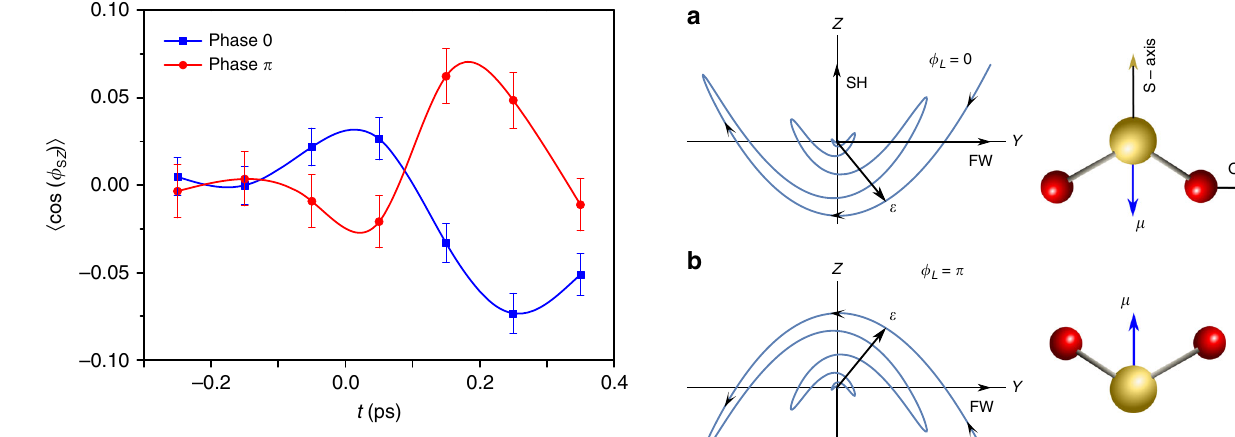
Fig. 5 Time-dependent orientation factor, 〈 cos ϕ S Z 〉 ( t ). Orientation factor as a function of a delay between OTC and the probe pulse for two relative phases ϕ L = 0, π . Around t = 0, ionization leads to an increase/decrease in the orientation, while the delayed orientation peaks result from hyperpolarizability interaction. Error bars represent the uncertainty propagated during data analysis according to Gaussian ’ s propagation law